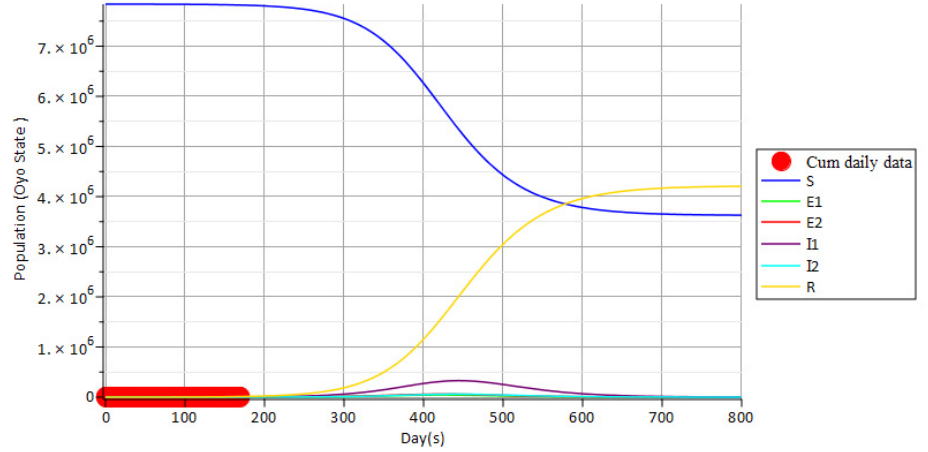
Figure 14. =The SE 1 E 2 I 1 I 2 R and cumulative daily infectious individuals from NCDC